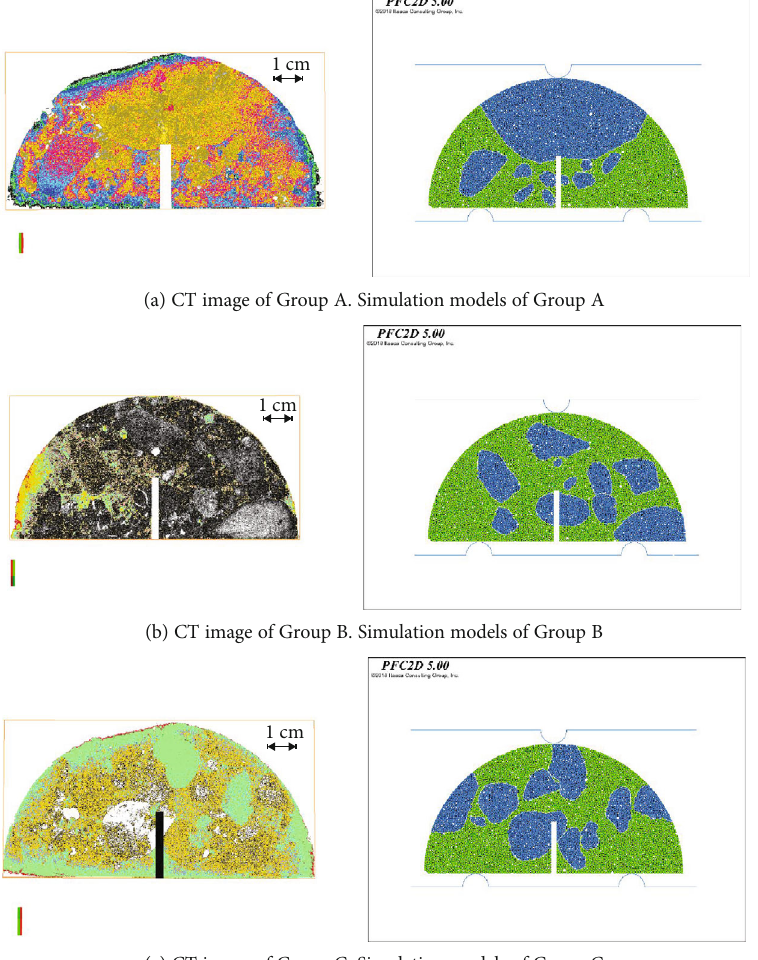
Figure 10: Simulation models for fracture toughness tests. The selected three sets of test pieces are all semicircular with a diameter of 0.10m. Their mesoscopic structure is representative. There is a critical gravel above the prefabricated crack of specimen A. The rock matrix mainly exists above the prefabricated cracks of specimen B. The tip of the prefabricated crack in specimen C is inside the gravel, and there are matrix and multiple gravels above